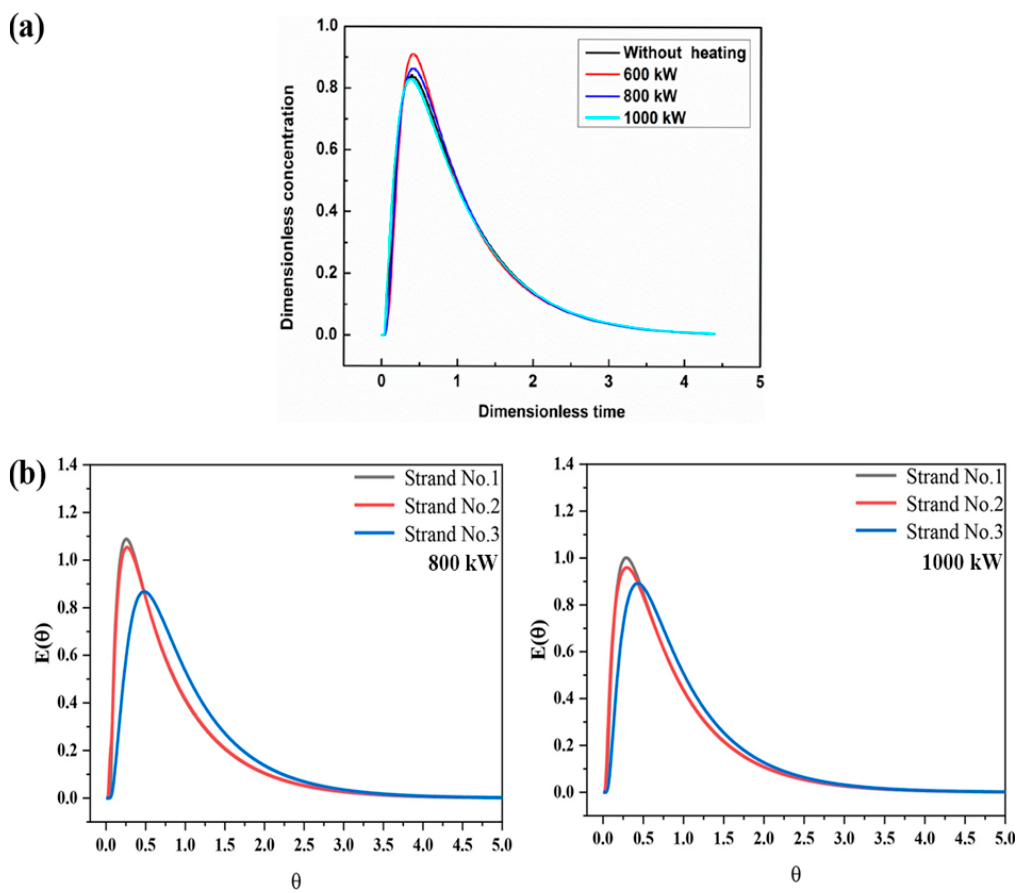
Figure 6. RTD curves in the tundish with different types of heating of power. ( a ) The single-flow dual-channel IHT [61]. ( b ) The dual-channel IHT [54] © The Minerals, Metals, & Materials Society and ASM International 2021. All rights reserved.